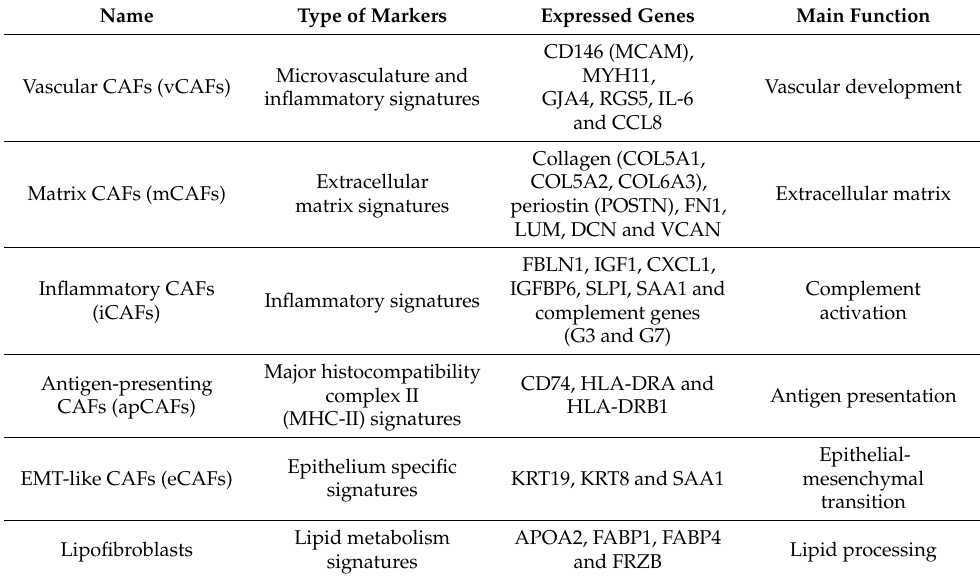
Table 1. Cancer-associated fibroblast (CAF) subtypes. Data extracted from a single cell RNAseq analysis carried out by Zhang et al., JHEP, 2020 [125]. This study described the presence of 6 different subsets of CAFs in iCCA, highlighting their different gene expression and